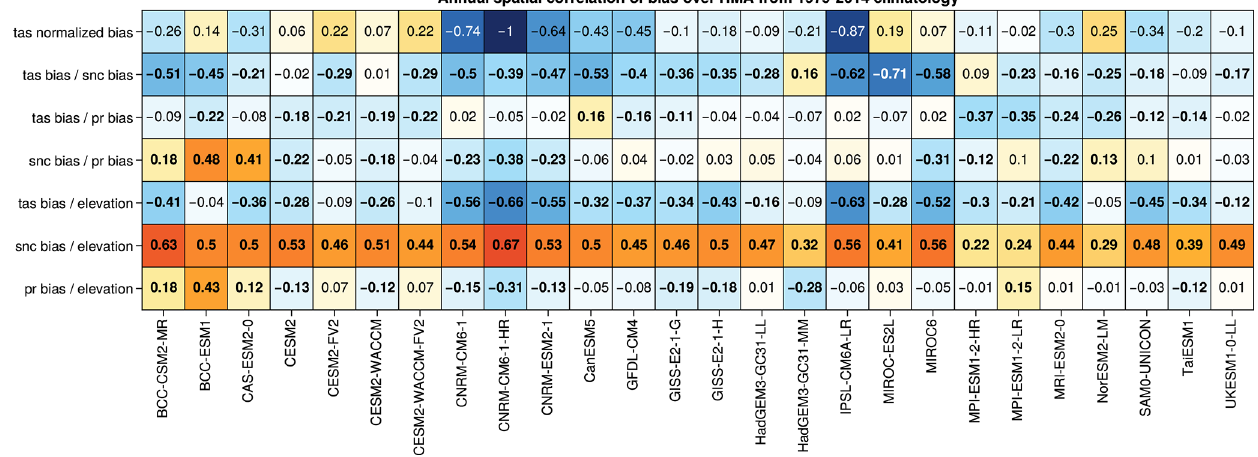
Figure 4. Pattern correlations of the annual model biases. The first row shows the temperature bias normalized with the strongest temperature bias found among the 26 models (CNRM-CM6-1-HR). The following rows show the pattern correlations computed between temperature and snow cover biases (second row), temperature and precipitation biases (third row), snow cover and precipitation biases (fourth row). The fifth to the seventh rows show the correlation between biases and surface elevation estimated from GMTED2010 for temperature, snow cover and precipitation. All biases are annual and computed over 1979–2014. Bold characters highlight significant correlation ( p value <